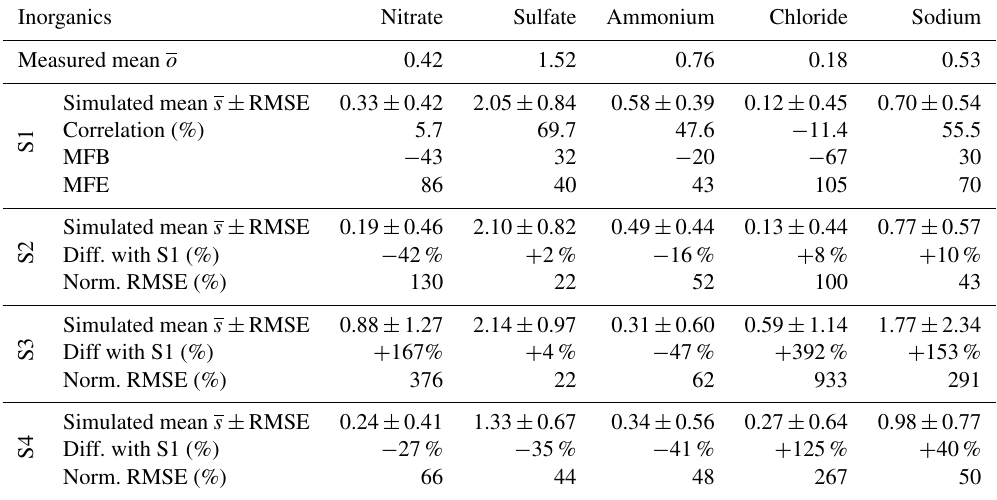
Table 9. Comparisons of simulated PM 10 inorganic daily concentrations to observations (concentrations are in µgm − 3 ) using S1, S2, S3 and S4 during the 2013 summer.